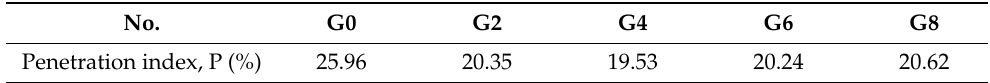
Figure 9. Photos of the crucible samples after the cup tests: ( a ) G0, ( b ) G2, ( c ) G4, ( d ) G6, and ( e ) G8. Table 4. Penetration indexes of the corroded samples.